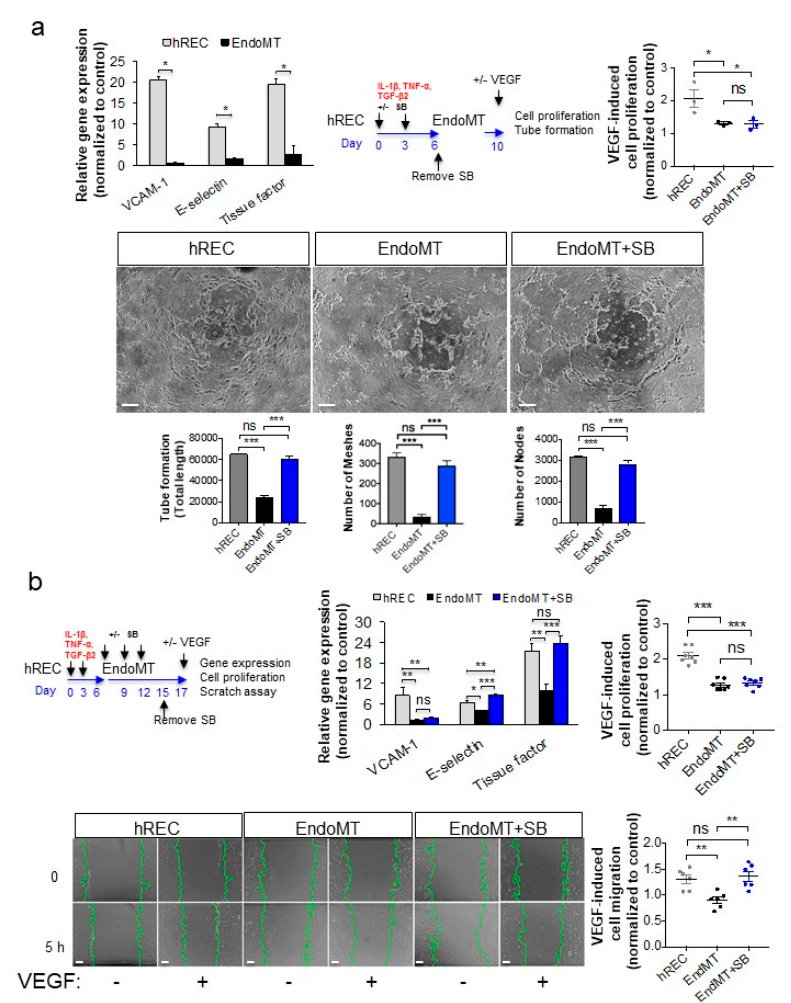
Figure 4. Treatment with an EndoMT inhibitor significantly restores VEGFA-mediated gene expression and endothelial cell functions in EndoMT cells. ( a ) To assess responsiveness to VEGFA, hREC, and EndoMT cells were treated with hVEGFA165 (10 ng/mL) for 2 h, then expression of genes encoding VCAM-1, E-selectin and TF was assessed by qPCR (top left panel). For the prevention study, cells were treated with SB203580 (10 μ M) during EndoMT induction, then four days later hVEGFA165 (10 ng/mL) was added. Cell proliferation was assessed using the MTT assay (top right panel), and VEGFA-induced cord/tube formation was assessed using a collagen gel assay (bottom panels). Equal numbers of viable hREC and EndoMT cells were used for these assays. Data = mean ± SEM, * p < 0.05, ** p < 0.01, *** p < 0.001 by 2-tail unpaired t-test, n = 6 independent wells for the first panel and n = 3 independent wells for the subsequent panels. In the micrographs, scale bar = 100 μ m. ( b ) For the intervention study, EndoMT cells were treated with SB203580 (10 μ M) for 9 days, starting